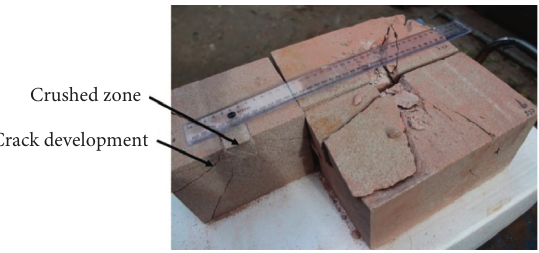
Figure 7: Observation of rock